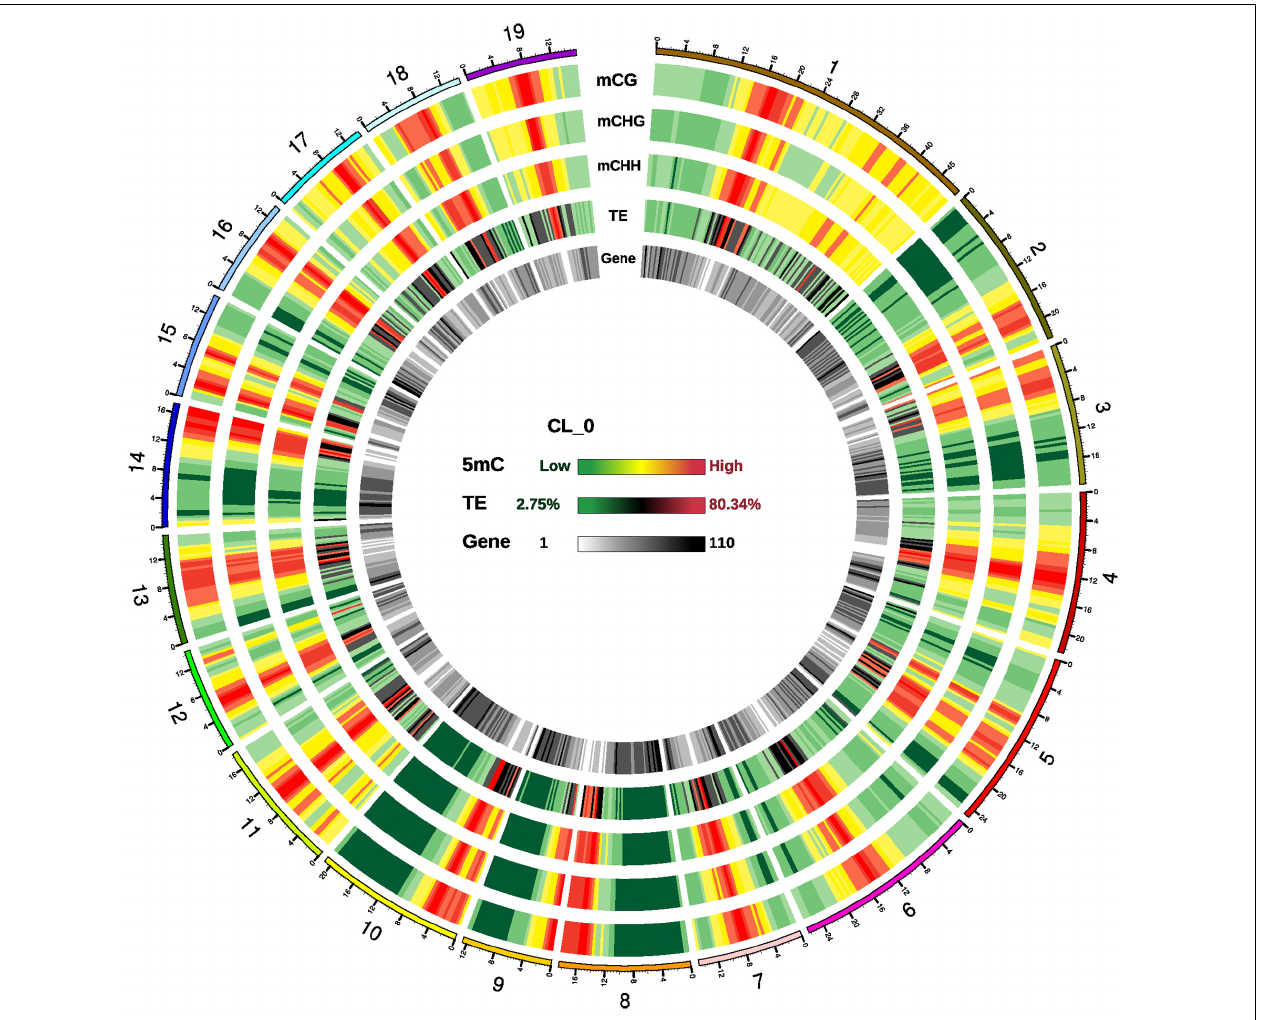
FIGURE 1 | Epigenomic analysis in P. trichocarpa leaves. Density plot of 5-methylcytosine in three sequence contexts [mCG, mCHG, and mCHH (where H = A, C, or T), transposable elements (TEs), and genes in sample CL_0]. High density regions of cytosine methylation were distributed in all 19 chromosomes, which were enriched in TEs but sparse in genes. Chromosome numbers and scales are indicated on the outer rim. Chromosome distribution of 5-methylcytosine in all samples are similar, and not present in here.